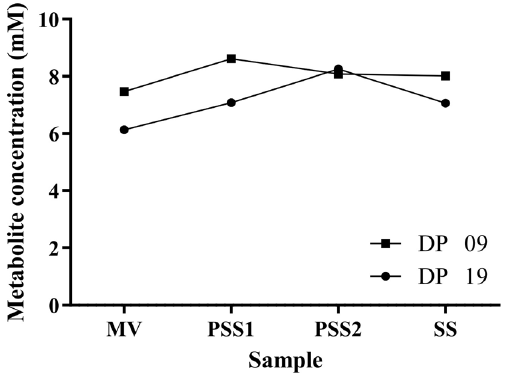
Figure 1. pCA concentration during anaerobic glucose-limited chemostat cultivations of S. cerevisiae SA-1 strain. MV medium vessel, PSS1 first pre-steady-state, PSS2 second pre-steady state; SS, steady-state. DP09 and DP19 code for the duplicate runs. The pre-steady-state samples (PSS1 and PSS2) represent samplings at 24 and 48 h after starting the feeding,